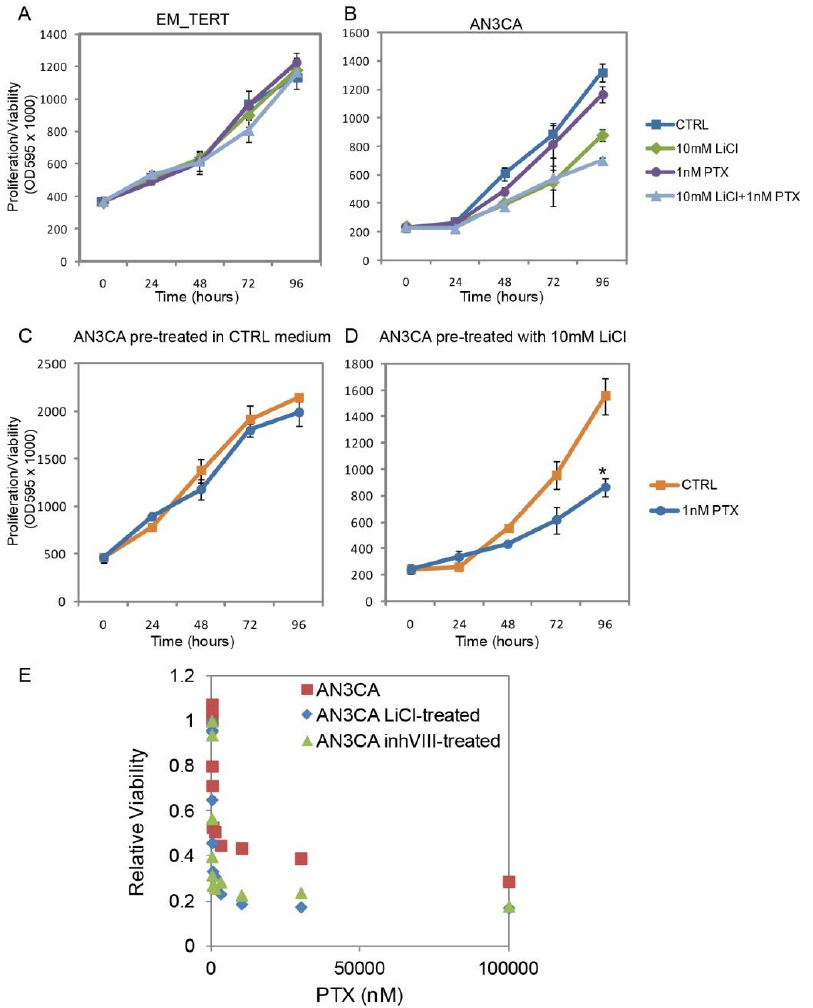
Figure 6. GSK3β inhibition sensitizes endometrial cancer cells to Paclitaxel (PTX). ( A , B ) Treatments with LiCl, PTX or the combination of the two agents did not interfere with EM-TERT cell growth, whereas combo-treatment showed a greater growth inhibition on AN3CA cells compared with either single agent treatment; ( C , D ) AN3CA cell exposed to LiCl for 96 h prior to PTX treatment showed a dramatically improved response to this drug; ( E ) AN3CA cells previously exposed to control, 10 mM LiCl or µM GSK3β inhibitor VIII were treated for 72 h with various concentrations of PTX. Cell survival was determined by MTT assays and calculated as the ratio of viable cells with respect to non-PTX-treated controls. IC values were determined by using the ED50plus online 50 software